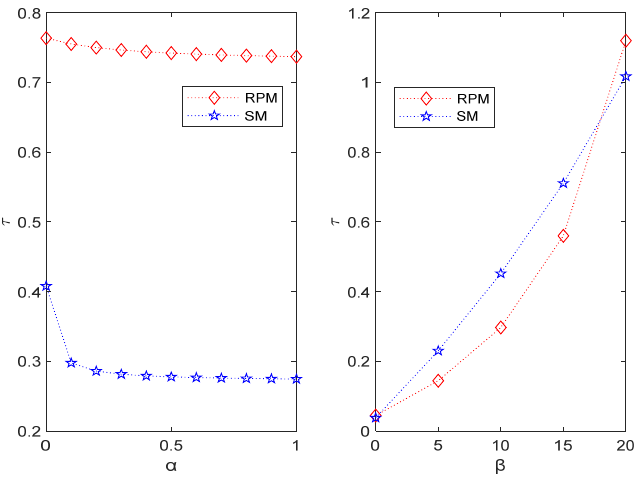
Figure 3. Collection rate under RPM and SM vs. fixed cost coefficient ( left ) and environmental benefit coefficient ( right